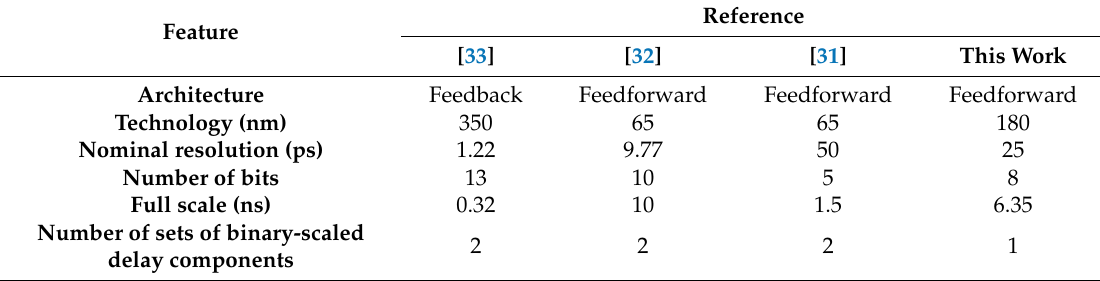
Table 4. Comparison of this work to previous works on SA-TDCs.